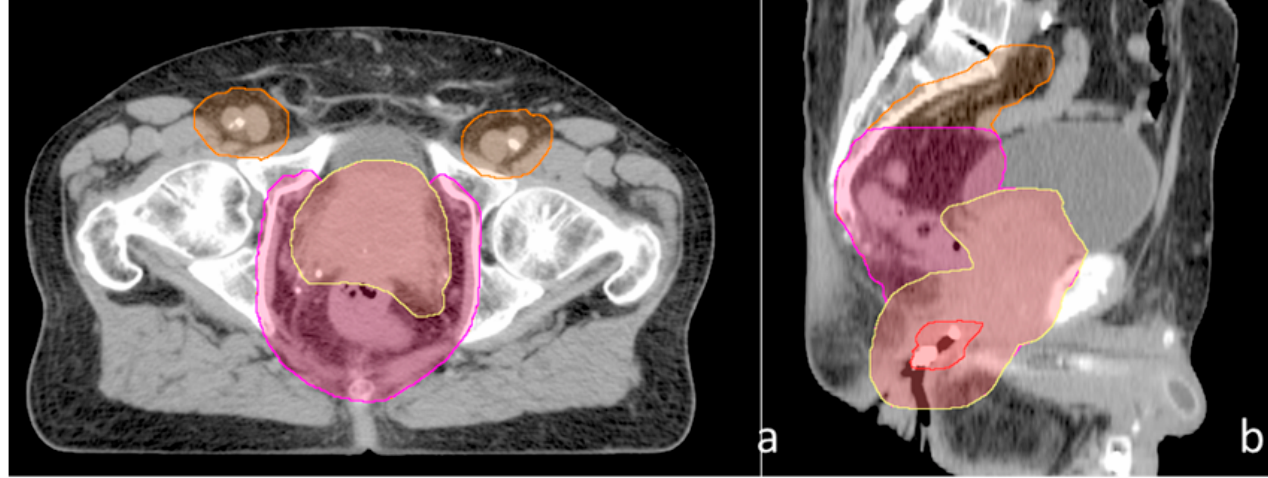
Figure 1. ( a ) Axial view, ( b ) sagittal